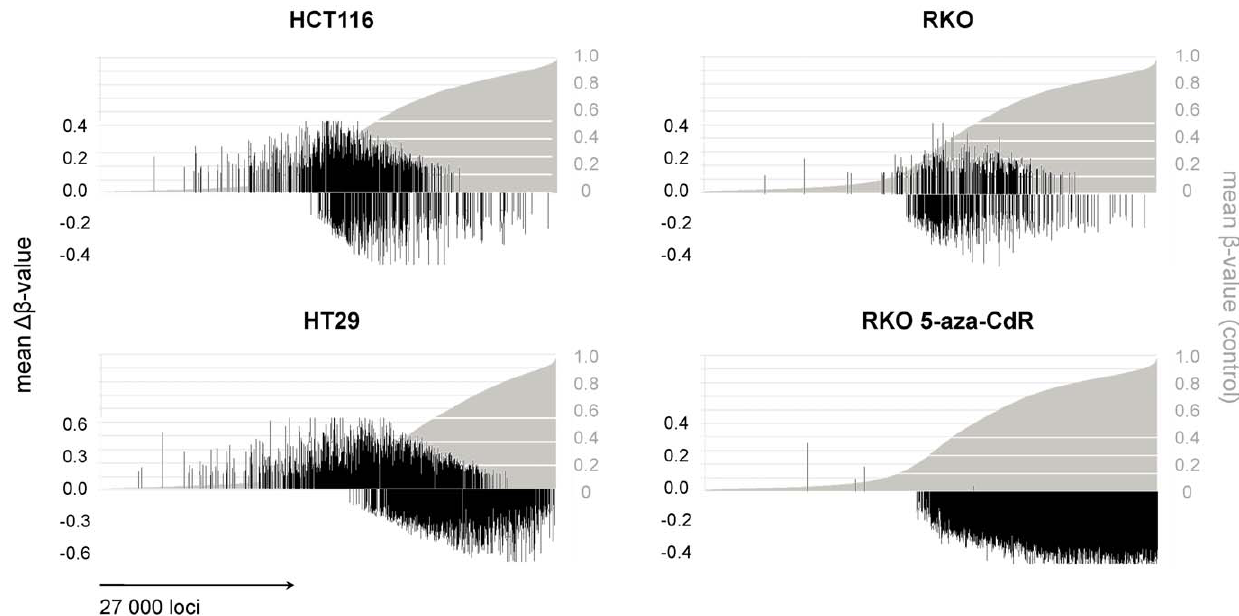
Figure 5. Curcumin-mediated changes in DNA methylation differ among 5-aza-CdR treated cells. The validated CpG loci of the cell lines were ordered in ascending order. The figure represents the magnitude and the location of curcumin-affected CpG loci in relation to control cell lines. The gray curve represents the distribution of the CpG loci in ascending order. The black lines represent the Db -values ( b control– b treatment) matching the control cells. The treatment with curcumin was associated with both hyper- and hypomethylation changes, predominantly in partially-methylated CpG loci, while 5-azaCdR treatment was responsible for non-selective hypomethylation.